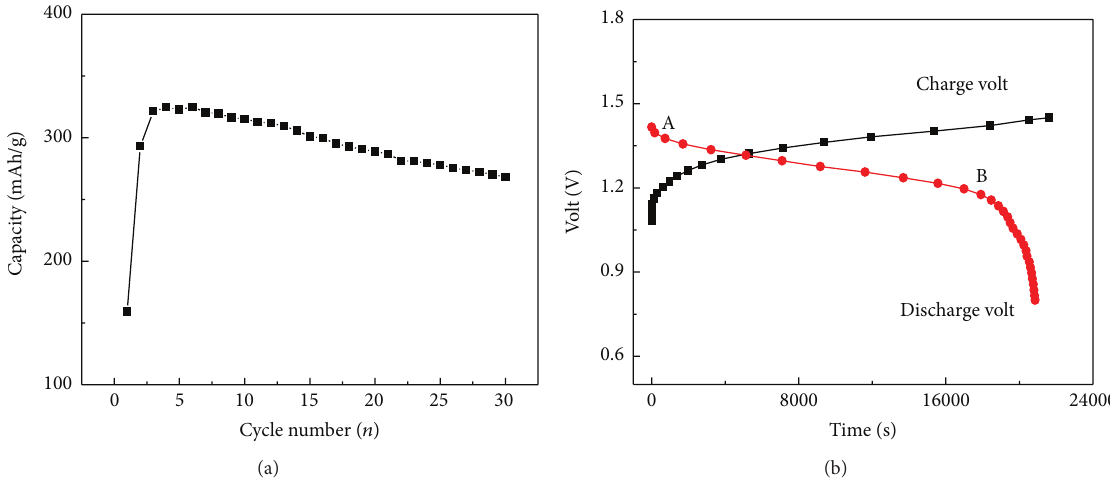
Figure 3: Discharge capacity and discharge profile for La 0.96 Ce 0.04 Mg 0.15 Al 0.05 Ni 2.8